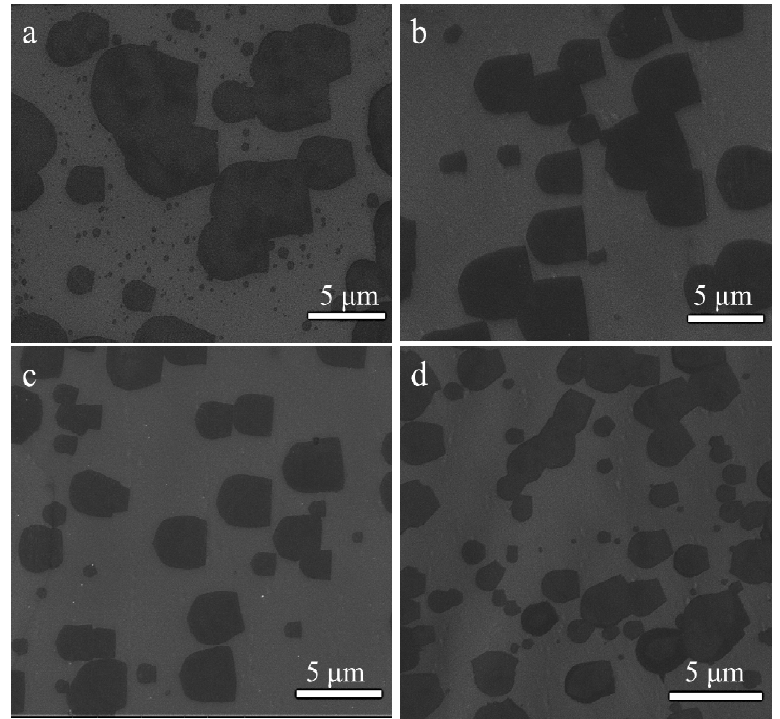
Figure 3. ( a – d ) SEM images of the growth of U-shaped graphene under different methane flow rates (20, 25, 30 and 35 sccm, respectively).